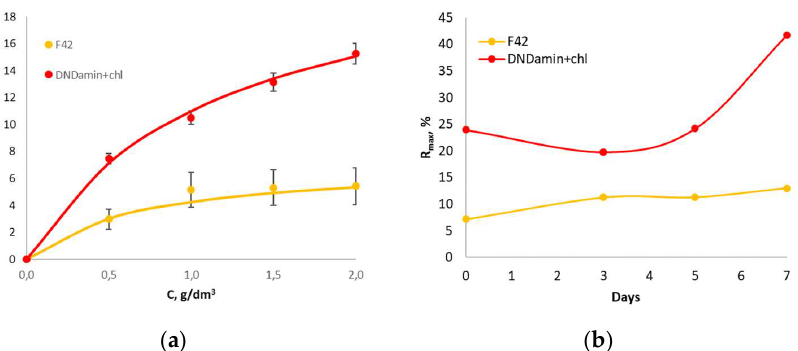
Figure 9. ( a ) Dependence of the analytical signal R on the glucose concentration for unmodified material F42 and DNDamine + chl; ( b ) Dependence of the R max value on the incubation time. We traced the evolution of the R max parameter with the time of in vivo incubation (Figure 9b). A slight almost linear growth is observed for the untreated material, while a significant increase is witnessed for the DNDamine + chl coating on the 7th day of incu- bation. Comparison with the results of confocal microscopy and respiratory MTT assay allows us to conclude that in the first 5 days the observed response is provided by cells adhered to the sensor surface due to the cell wall interaction. On the 7th day, the cells are fixed by means of the polysaccharide matrix, which provides much better retention on the surface and a noticeably greater response to glucose injections. Nevertheless, it is im- portant to note that even 1.5 h of incubation is sufficient for the formation of a bioreceptor